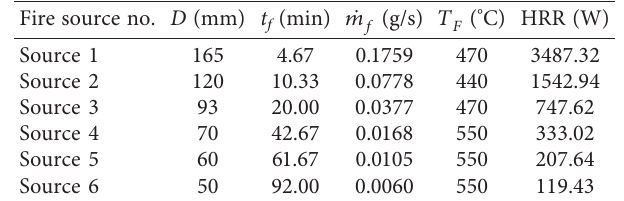
Figure 9: Evolution of temperature in the persistent zone of the flame during the four repeated tests: case of source 6. Table 5: Application of Cochran’s test to data of the confined experiments.